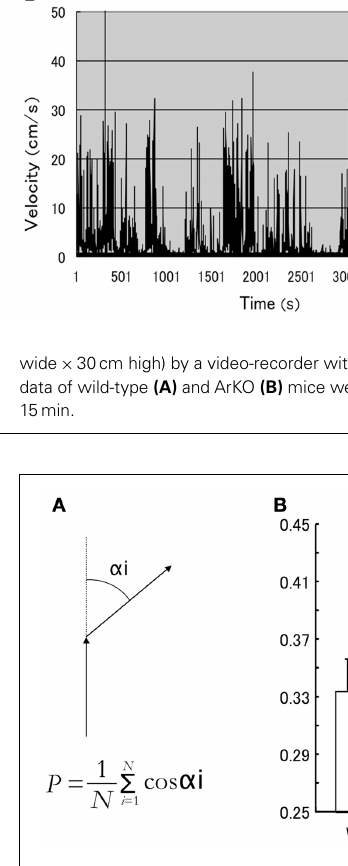
FIGURE 7 |The parallelism index of wild-type,ArKO, andArKO/bsArTG mice as a parameter of locomotor activity. The parallelism index, a characteristic feature of locomotor or exploratory movement, was calculated from video-recorded locomotor activities of males (hatched bars) and females (open bars) of wild-type ( n = 9), ArKO ( n = 11), and ArKO/bsArTG ( n = 9) mice aged 14–16weeks using behavioral analysis software SMART (B) .The index value elicited from the formula shown in the (A) approaches + 1 when the movement is straight ahead, and approaches 0 and − 1 when the test mouse moves rightward/leftward, and backward,